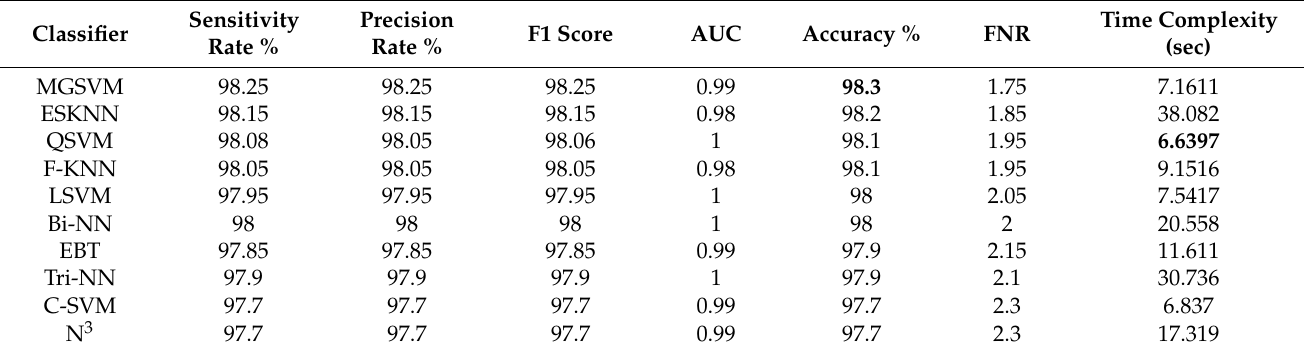
Table 6. Classification results of INbreast dataset using original images based on fine-tuned deep model features.